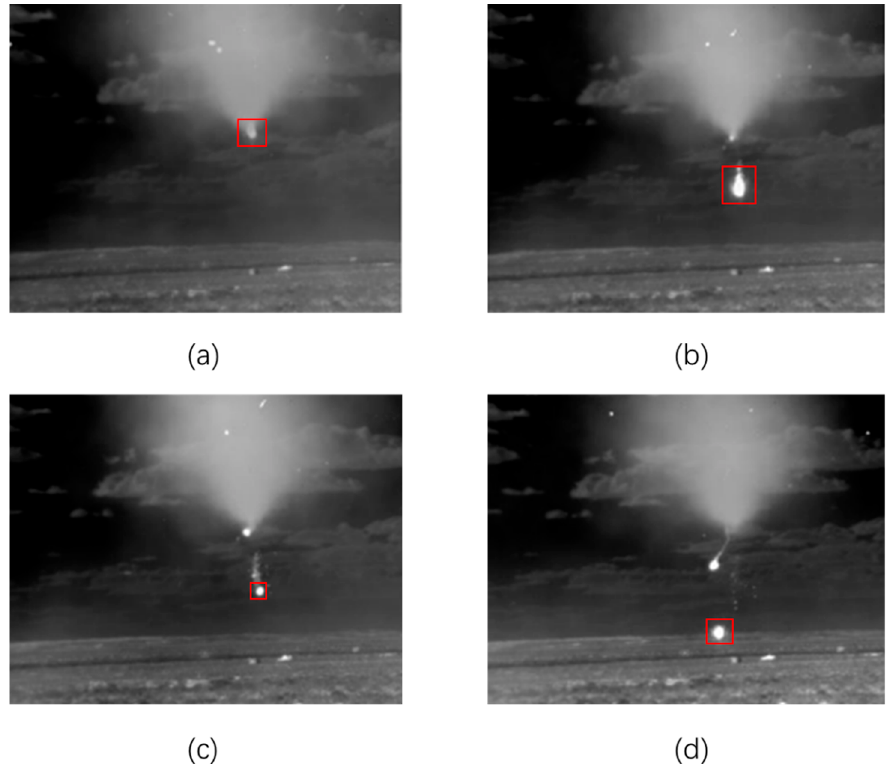
Figure 1. Continuous frames of infrared point target abnormal events. ( a ) The normal flight state of the target. ( b ) The target is separated, and the debris is separated from the main body. ( c , d ) Debris and the main target body move together [2].